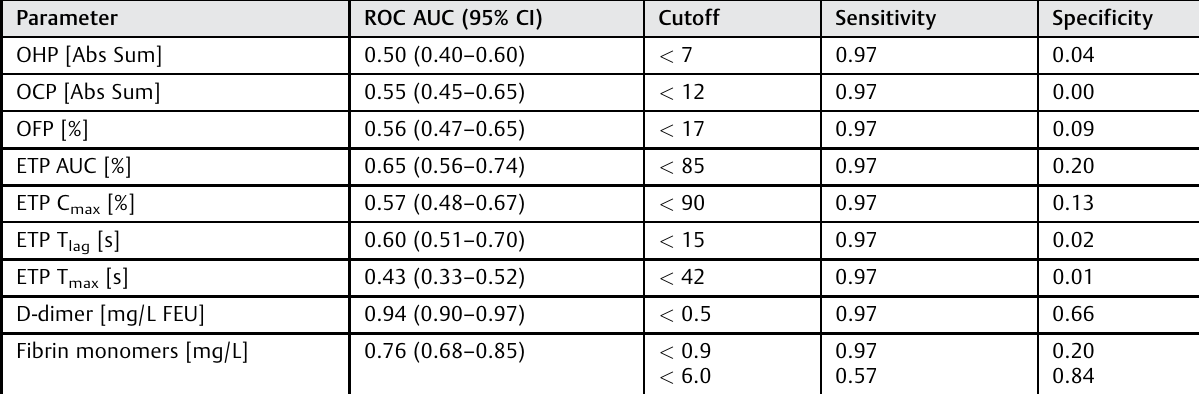
Table 3 Diagnostic accuracy of the evaluated assays presented as areas under the ROC curve and as sensitivity and speci fi city at a cutoff with sensitivity equal to D-dimer and the CLSI requirements for assays to exclude venous thrombosis